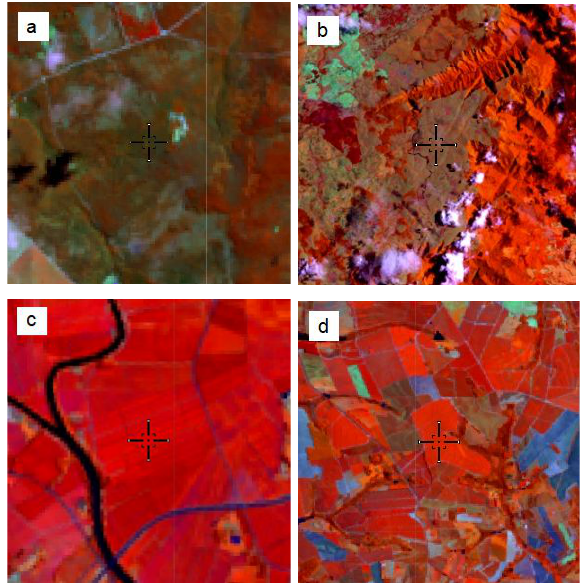
Figure 5a. Savanna Formation; Figure 5b. Grassland Formation; Figure 5c. Annual Crop; Figure 5d. Semi-Perennial Crop.